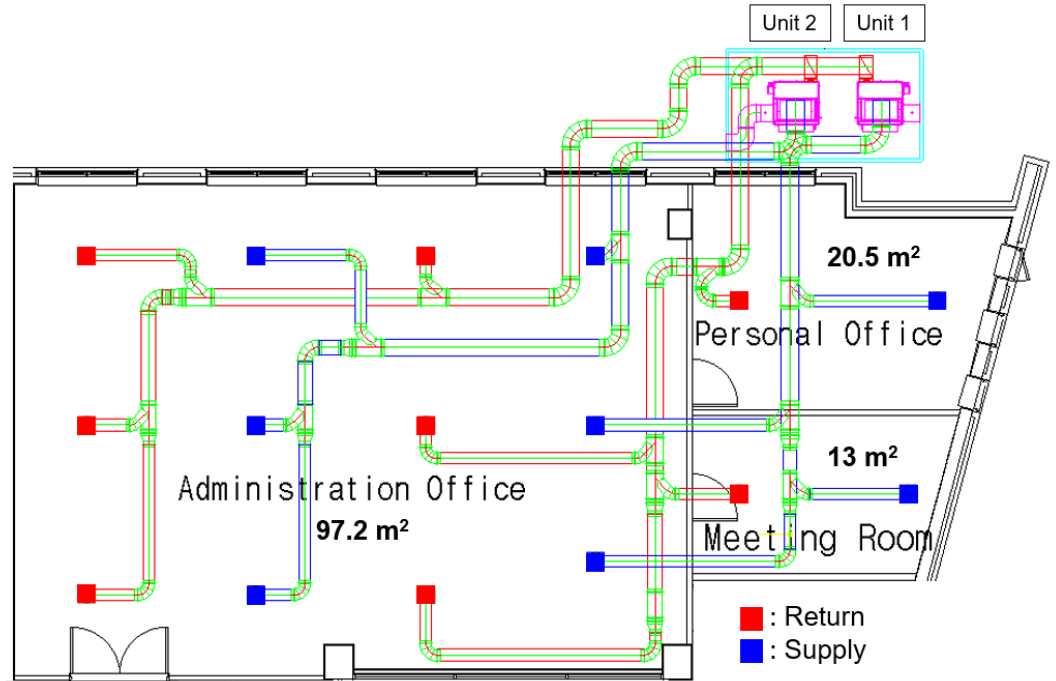
Figure 3. Floor plan of conditioned spaces with air-conditioning ducts.